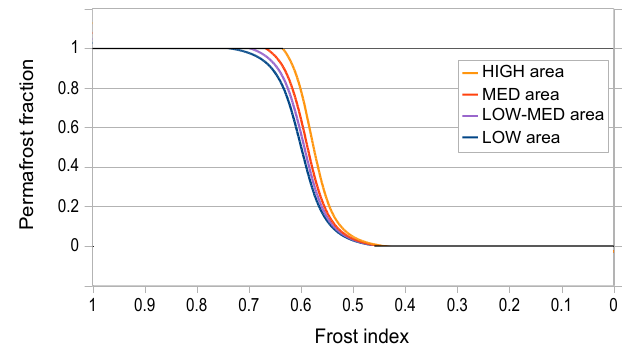
Figure 11. CLIMBER-2P model for permafrost fraction of the land in a grid cell from frost index (snow corrected). Range of areas is within the range of estimates for present-day land area underlain by permafrost by Zhang et al. (2000). Permafrost fraction is limited between 0 and 1. Zhang estimate for total permafrost area is 12.21